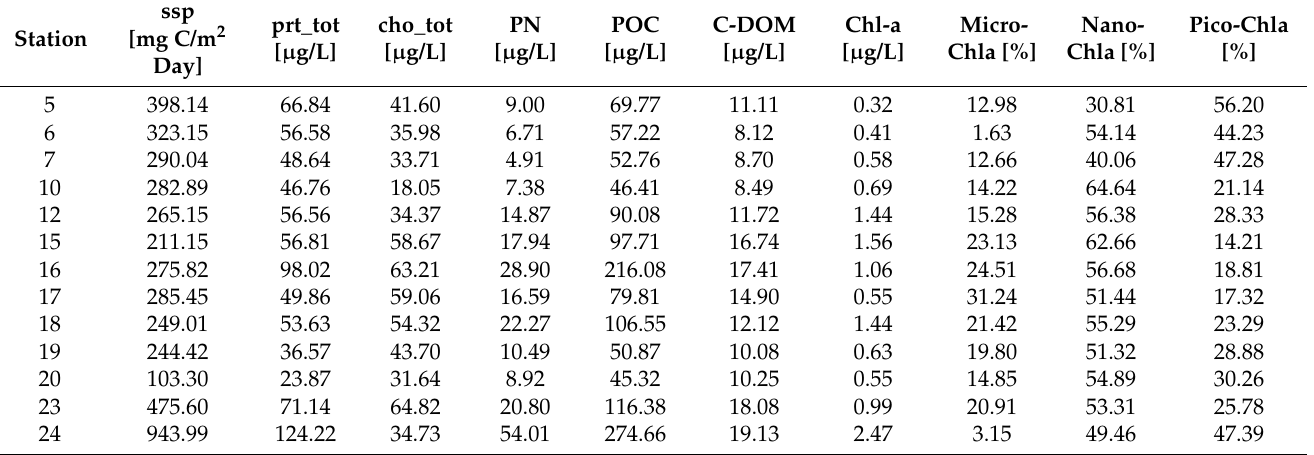
Table 2. Biogeochemical parameters determined for the sequenced stations. spp—surface primary productivity; prt_tot—total proteins; cho_tot—total carbohydrates; PN—Particulate Nitrogen; POC— Particulate Organic Carbon; C-DOM—C fraction of Dissolved Organic Matter; Chl-a—Chlorophyll-a; Picofraction of